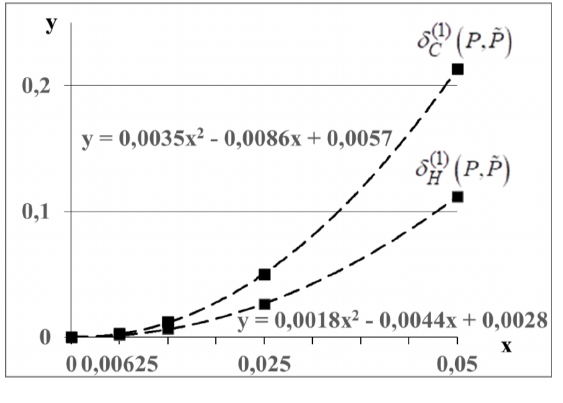
( P ) , δ (1) ( P ) , - - - graphs of H C